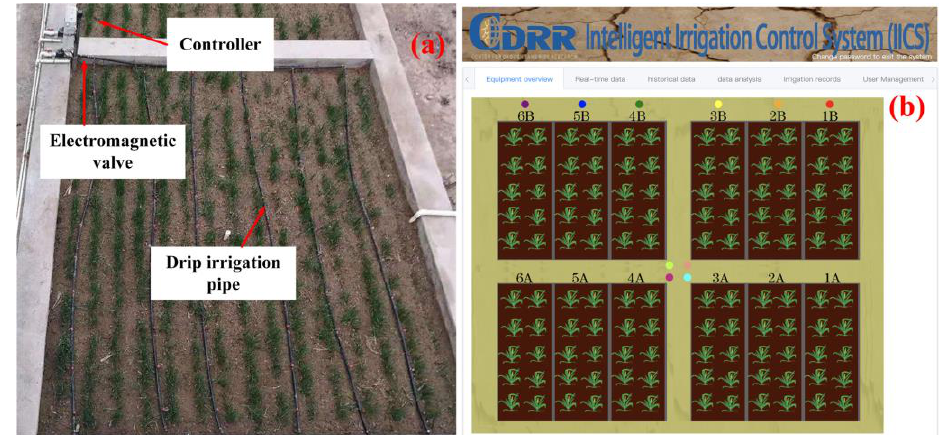
Figure 4. Hardware ( a ) and software ( b ) of automatic irrigation system (AIS). Each data collector controls two pots (A and B). controls two pots (A and